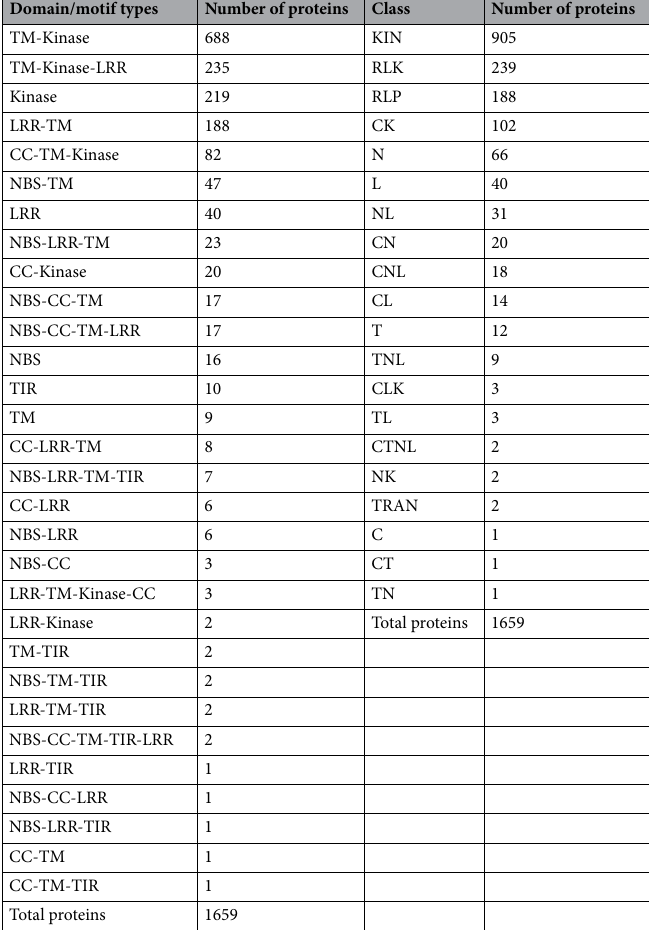
Table 4. Prediction of resistance genes domains/motifs present in proteins identified from whole genome sequencing of blackgram cultivar Pant U-31 with the help of DRAGO pipeline of Plant resistance gene